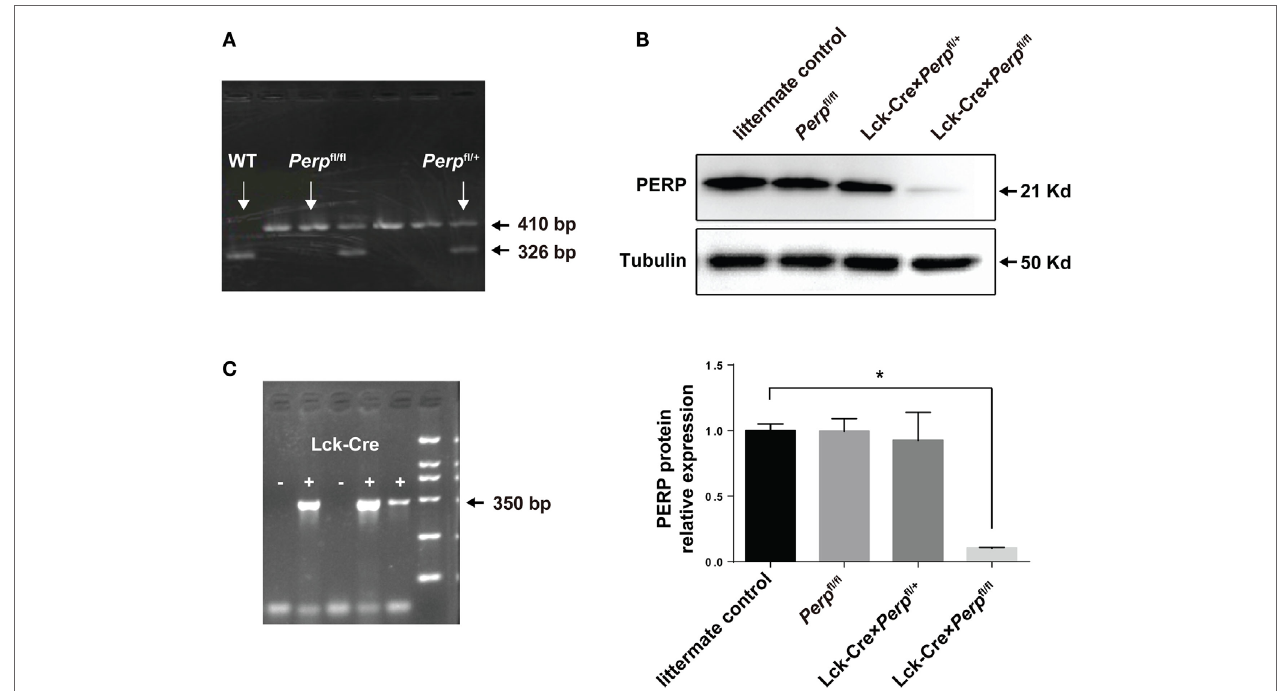
FigUre 1 | Identification of Lck-Cre × Perp fl/ + and Lck-Cre × Perp fl/fl mice. Following breeding Perp fl/fl mice, the F1 Lck-Cre × Perp fl/ + and Lck-Cre × Perp fl/fl mice were identified by PCR analysis of the genomic DNA from peripheral blood mononuclear cell for the Perp (a) and Lck-Cre (c) genes and Western blot analysis of splenic T cells (B) . Data are representative images or expressed as the mean ± SEM of each group from three separate experiments (* P <